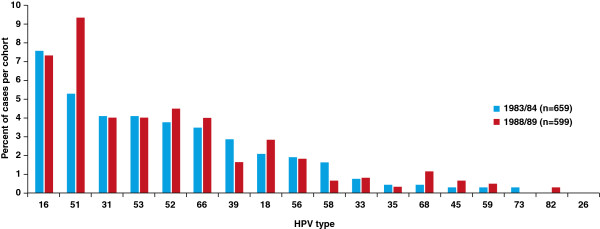
Type-specific prevalence of HR (16, 18, 31, 33, 35, 39, 45, 51, 52, 56, 58, 59, and 68) and putative HR (26, 53, 66, 73, and 82) HPV infection in 1983/84 and 1988/89 cohorts.